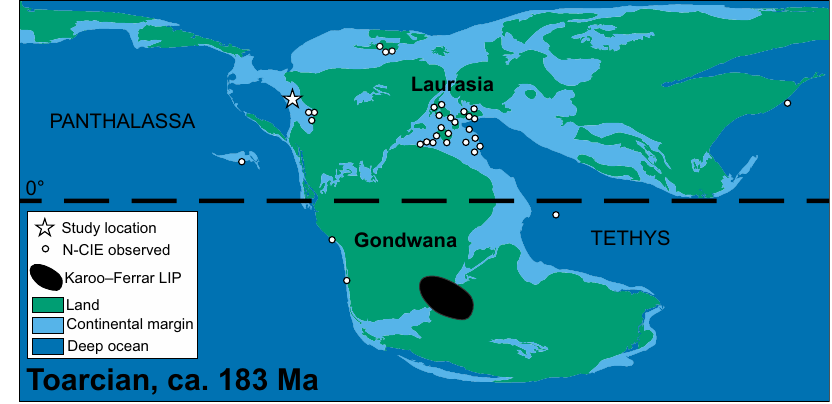
Fig. 1 | Global Toarcian paleogeography. Negative carbon isotope excursion locations 40 usedtoidentifytheToarcianOceanicAnoxicEventareshown.Thecore usedinthisstudywasdepositedalongthewesternmarginofLaurasia(proto-North